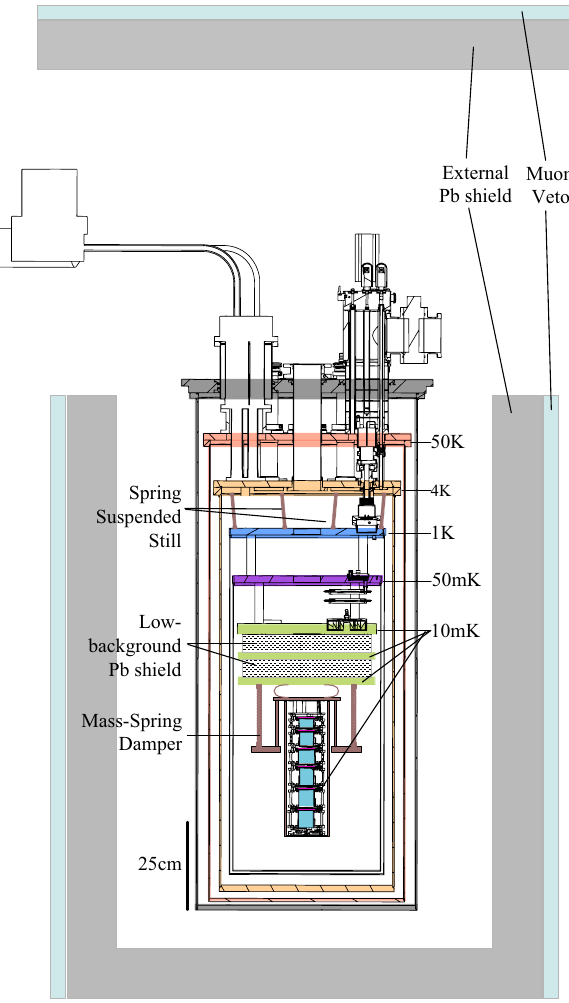
Fig. 2 Schematic diagram of the AMoRE-Pilot detector system